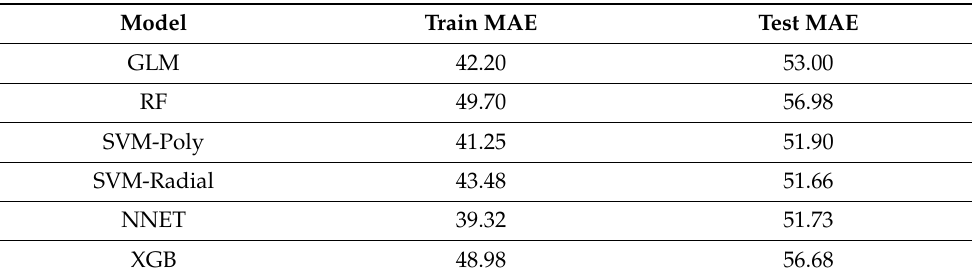
Table 7. Layer-2 Models Performance (IEEE 39-Bus System).